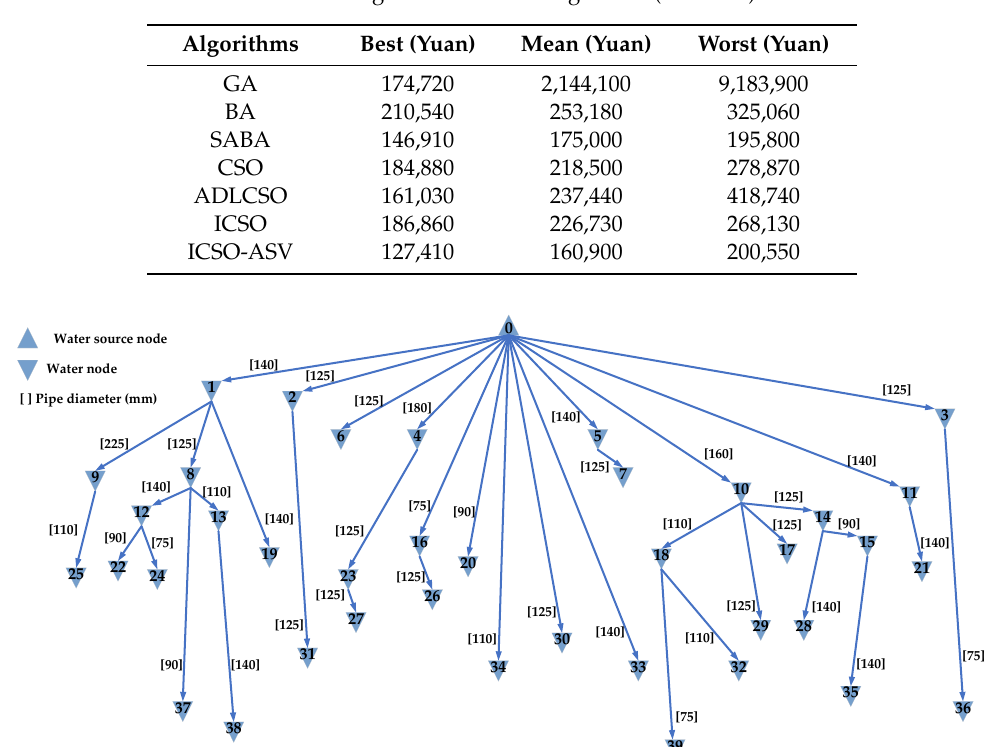
Table 8. Design results of each algorithm (40 nodes).